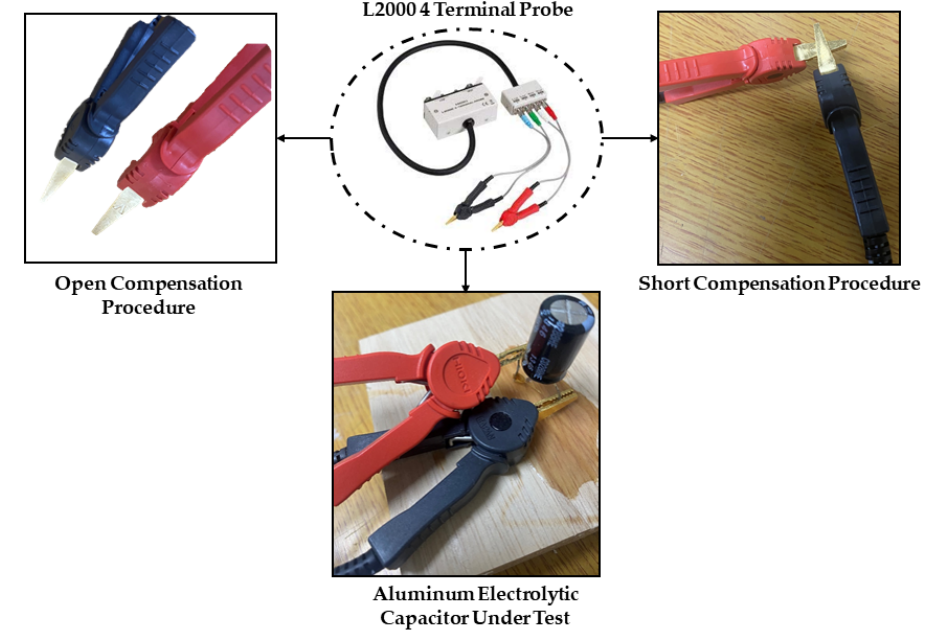
Figure 5. A detailed description of the open and short calibration procedure.